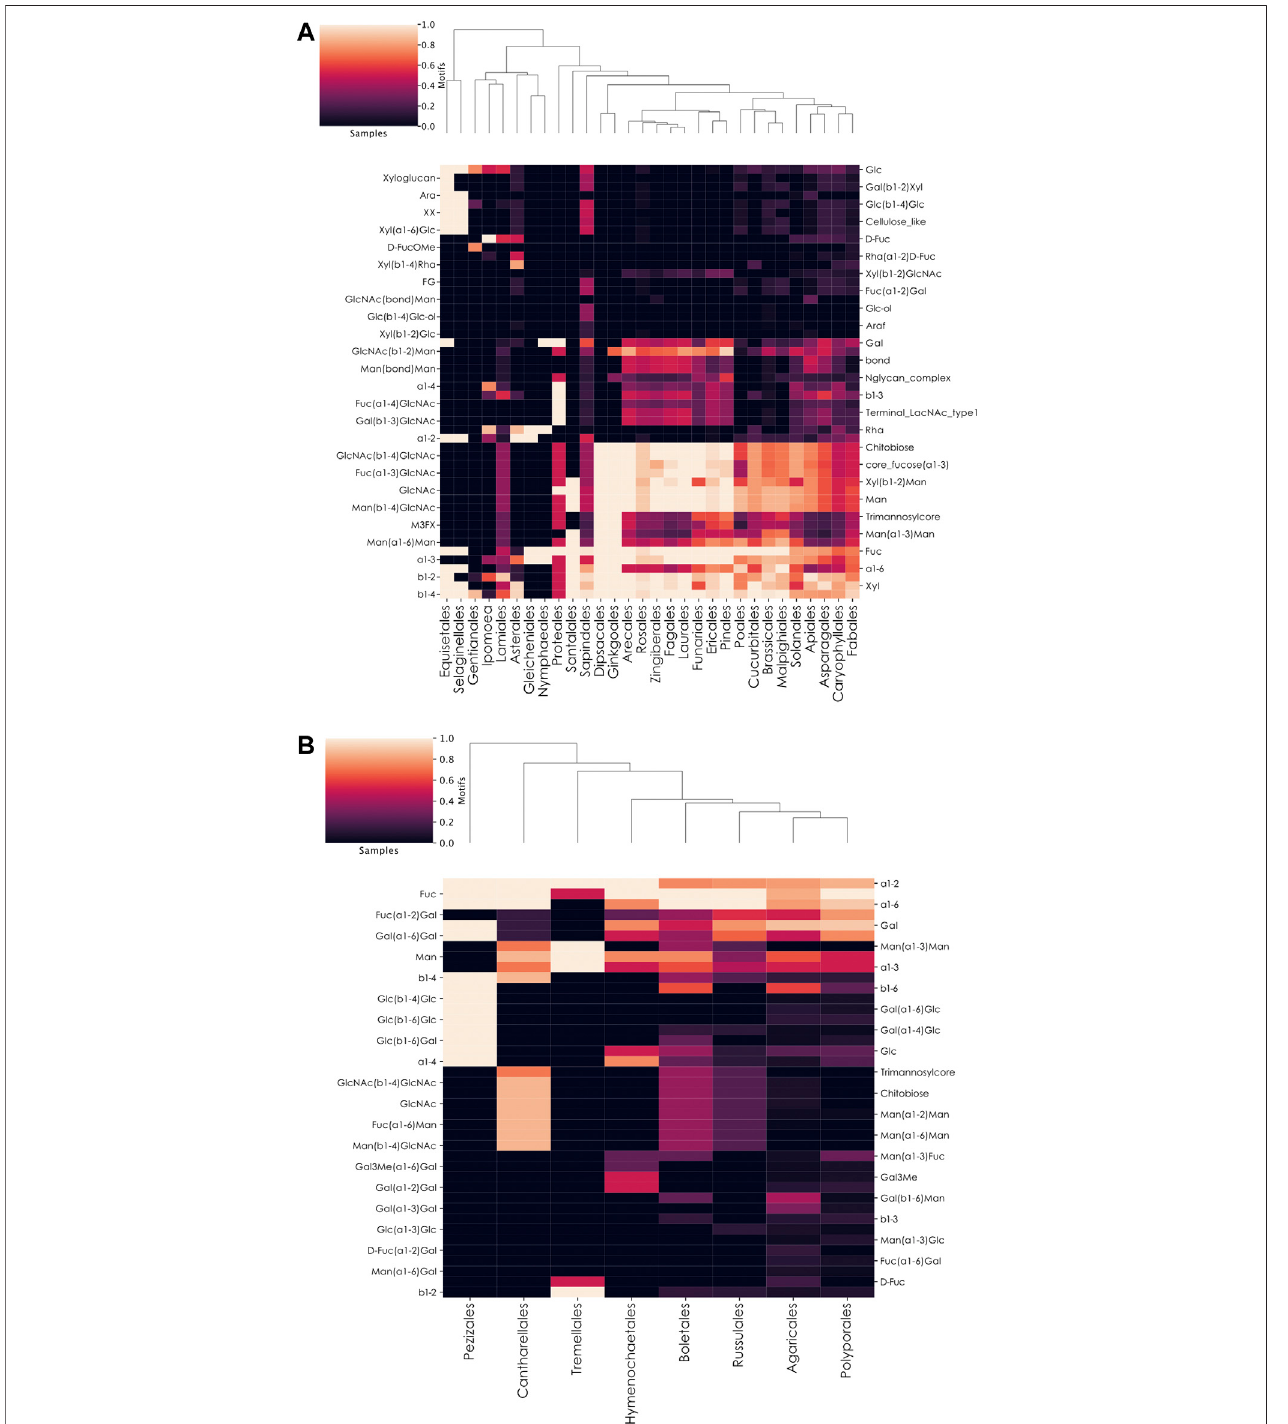
FIGURE 6 | Preferential motif usage in fucosylated glycans across plant and fungi orders. (A,B) Heatmaps of motifs in fucosylated glycans at the plant order- level (A) or fungi order-level (B) . These heatmaps represent the relative abundance of different motifs from fucosylated plant (A) or fungal (B) glycans in different taxonomic